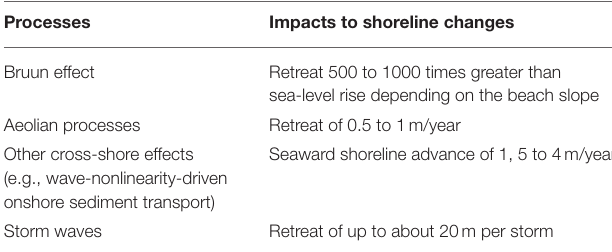
TABLE 1 | Order of magnitude for cross-shore sedimentary processes contributing to shoreline change for typical coastal settings in the Netherlands and Australia and for a closure depth of 10m (data from Stive,